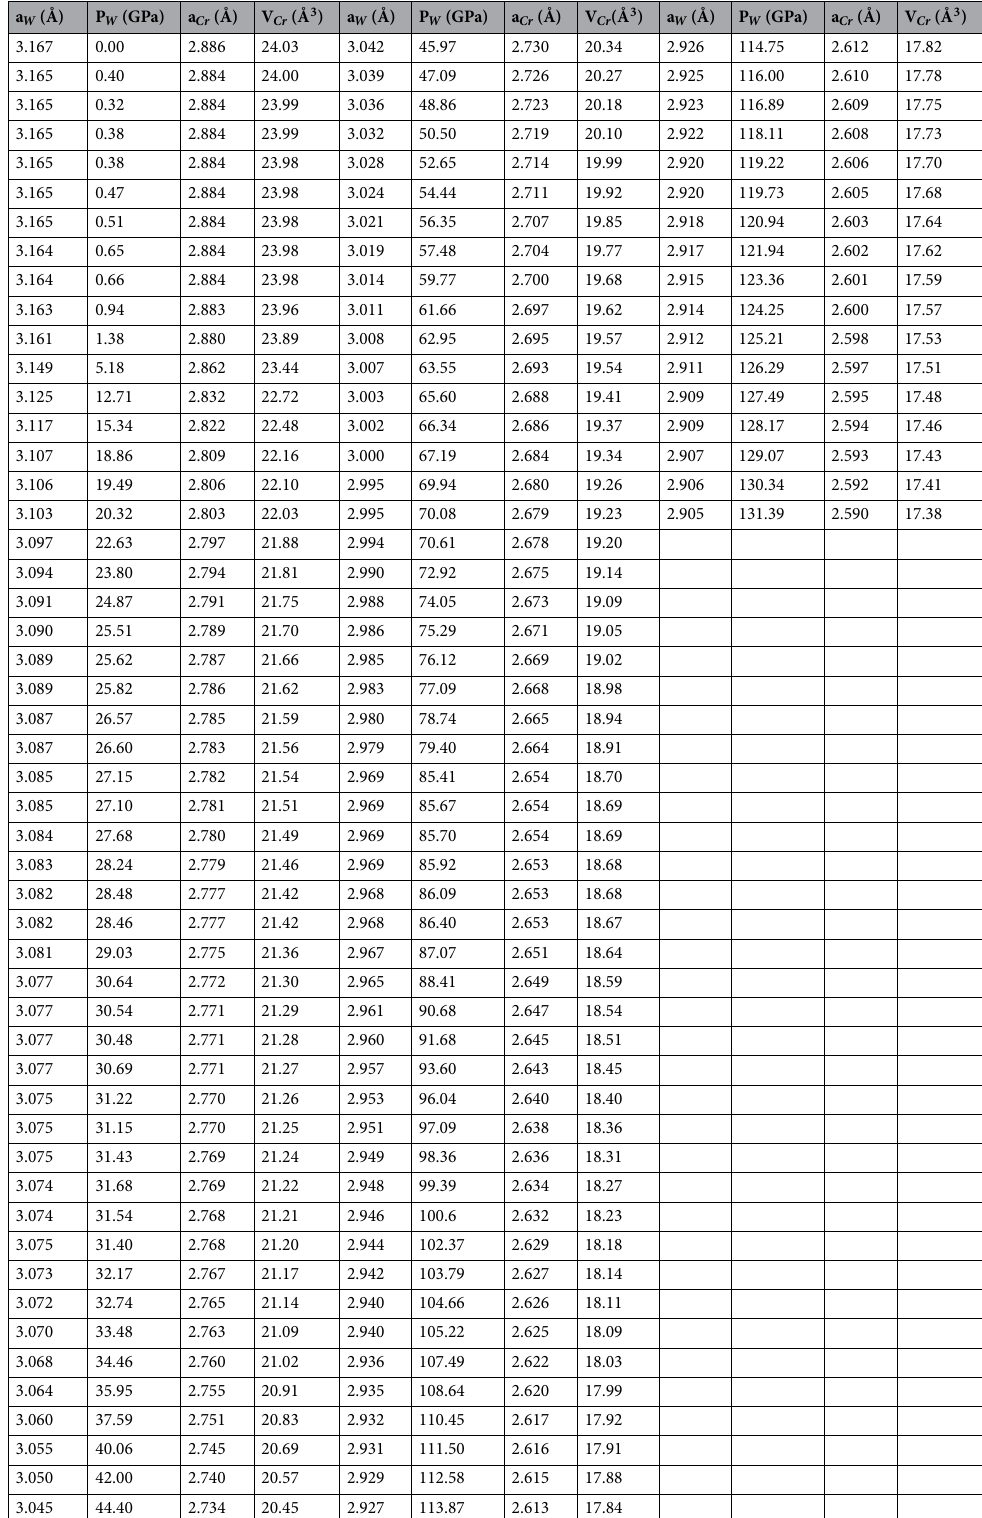
Table 2. The unit-cell parameters of Cr at ambient T as a function of P . All values are obtained using He as pressure transmitting medium. The lattice parameters of W, used for the P 67 measurements, are also reported. The experimental uncertainty of the lattice parameters is lower than 0.003 Å. The uncertainty on pressure measurement increases from 0.06 GPa at ambient P to 0.27 GPa at 200